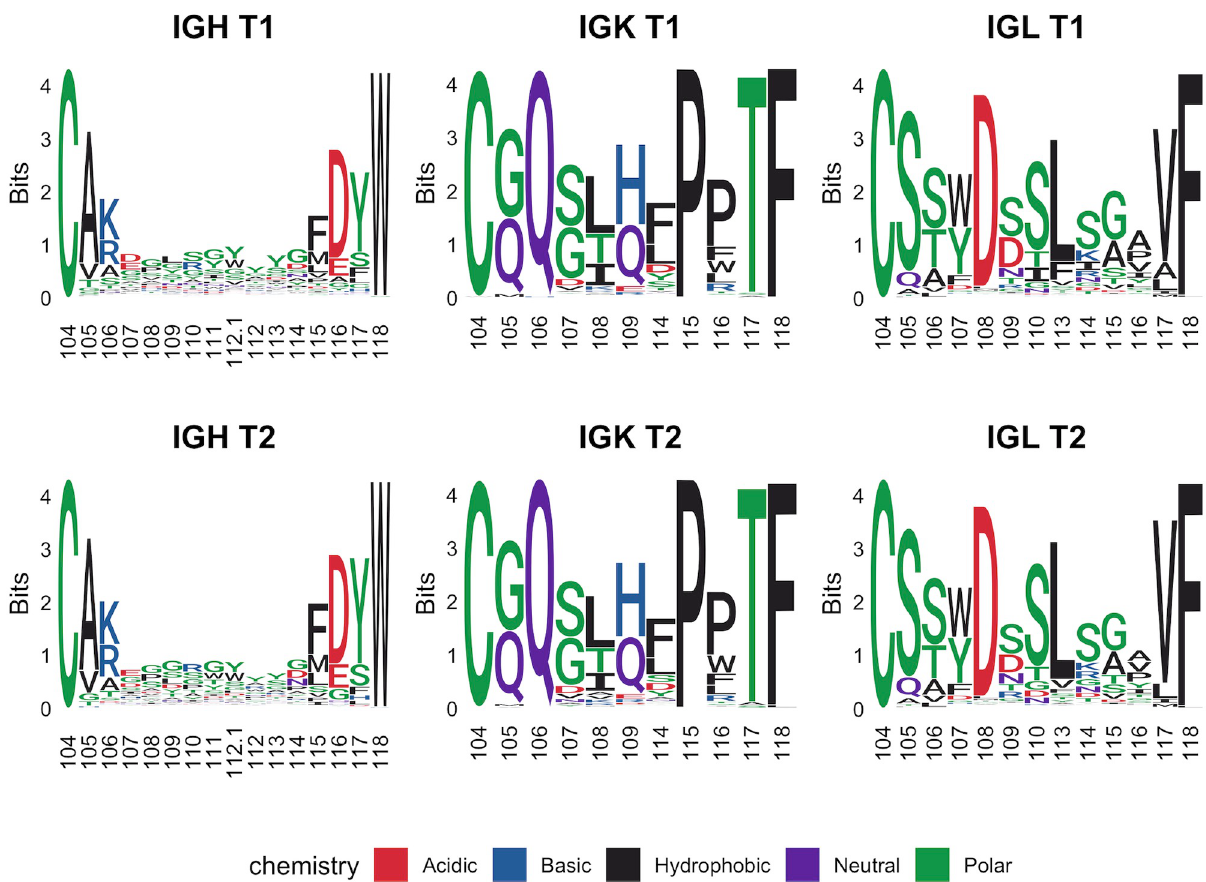
Fig 12. Sequence logos for IGH, IGK, and IGL cases at T1 and T2. Only CDR3s of the most common length for each chain (IGH = 14, IGK = 9, IGL = 11) were considered with amino acid letter height scaled to the amount of information contributed (bits) using Shannon entropy [35–37].